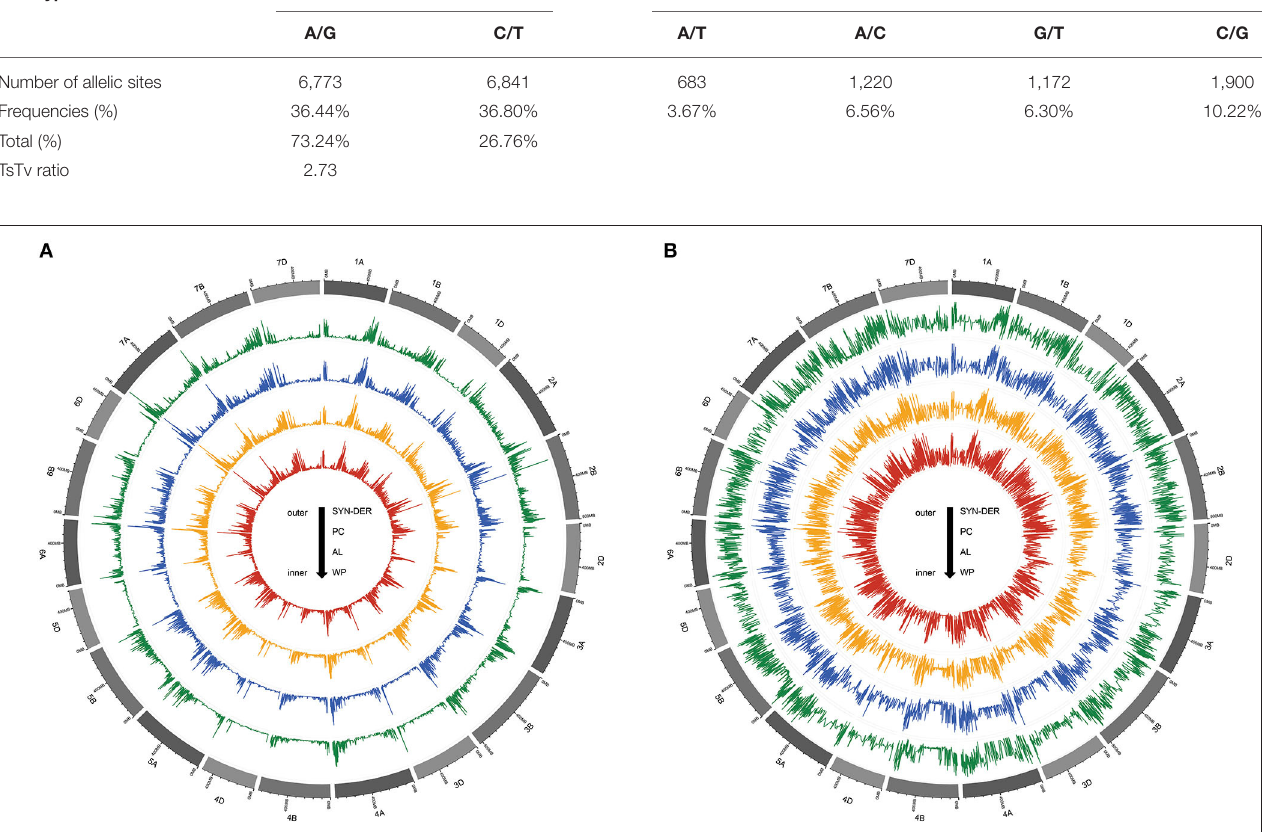
FIGURE 2 | The Circos plot, from outside to inside, illustrates the patterns of nucleotide diversity (A) and Tajima’D (B) values in synthetic-derived wheats (SYN-DER), commercially released Pakistan cultivars (PC), and advanced breeding lines (AL), respectively. Nucleotide diversity and Tajima’D are plotted along reference chromosomes in sliding windows of 1,000kb with a step size of